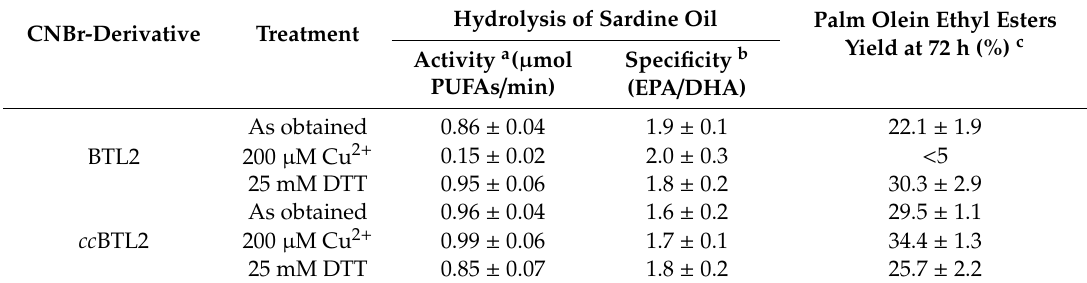
Table 3. Properties of immobilized BTL2 and ccBTL2 in the transformation of natural glycerides. Hydrolysis of Sardine Oil Palm Olein Ethyl CNBr-Derivative Treatment